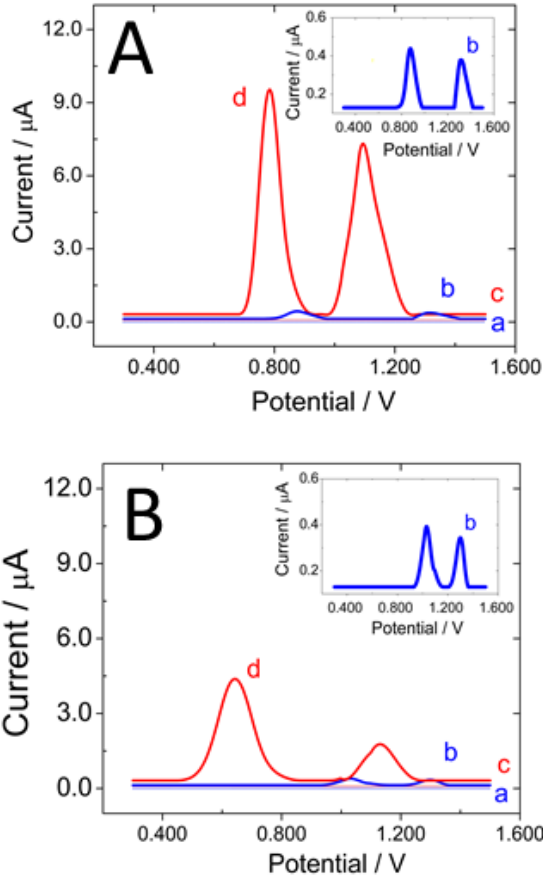
Figure 3. ( A ) Linear scan voltammograms obtained after baseline correction for: GCE (a), GCE/ds-DNAS (b), GCE/MWCNTs-PolyArg (c), and GCE/MWCNTs-PolyArg/ds-DNAS (d). ( B ) Linear scan voltammograms obtained after baseline correction for: GCE (a), GCE/ds-DNACT (b), GCE/MWCNTs-PolyArg (c), and GCE/MWCNTs-PolyArg/ds-DNACF (d). Supporting electrolyte: 0.200 M acetate buffer solution pH 5.00; dsDNAs accumulation: by deposition and solvent evaporation until dryness; dsDNAs Concentration: 100 ppm; scan rate: 0.050 V s − 1 .